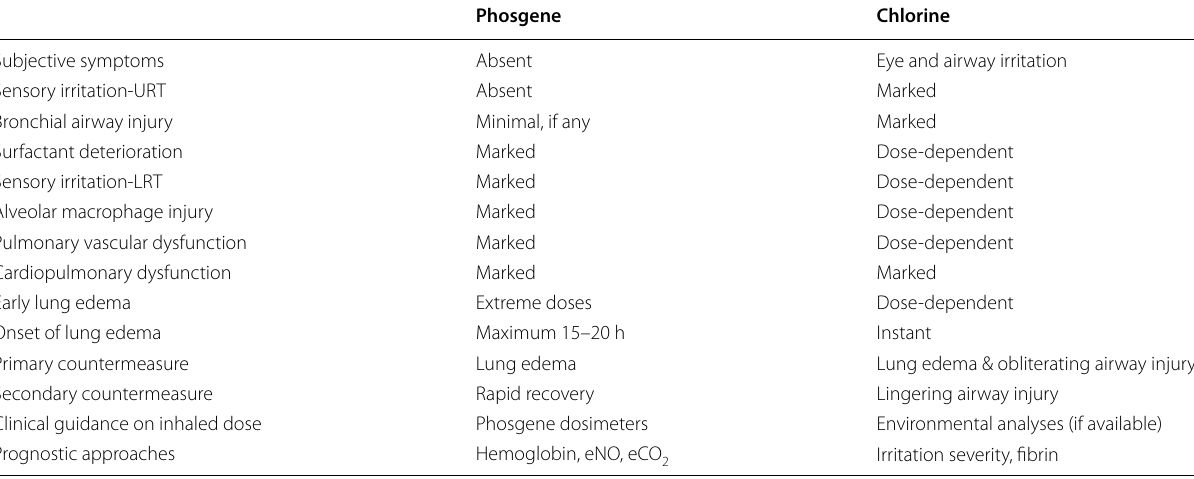
URT upper respiratory tract, LRT lower respiratory tract, eNO exhaled nitric oxide, eCO 2 exhaled carbon